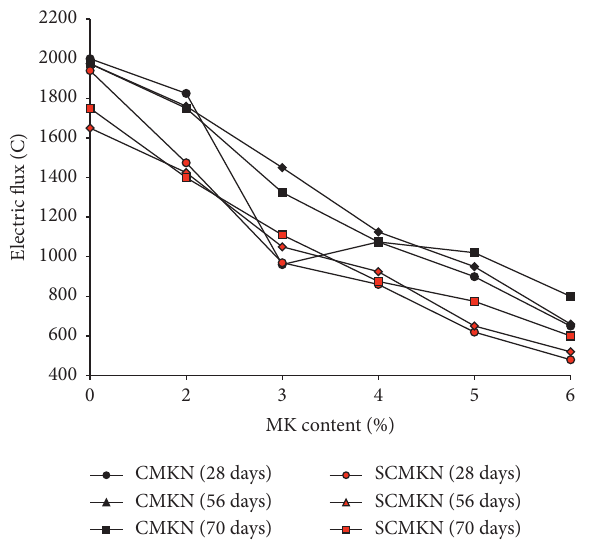
Figure 11: Total charge passing through concrete under RCPT [16].